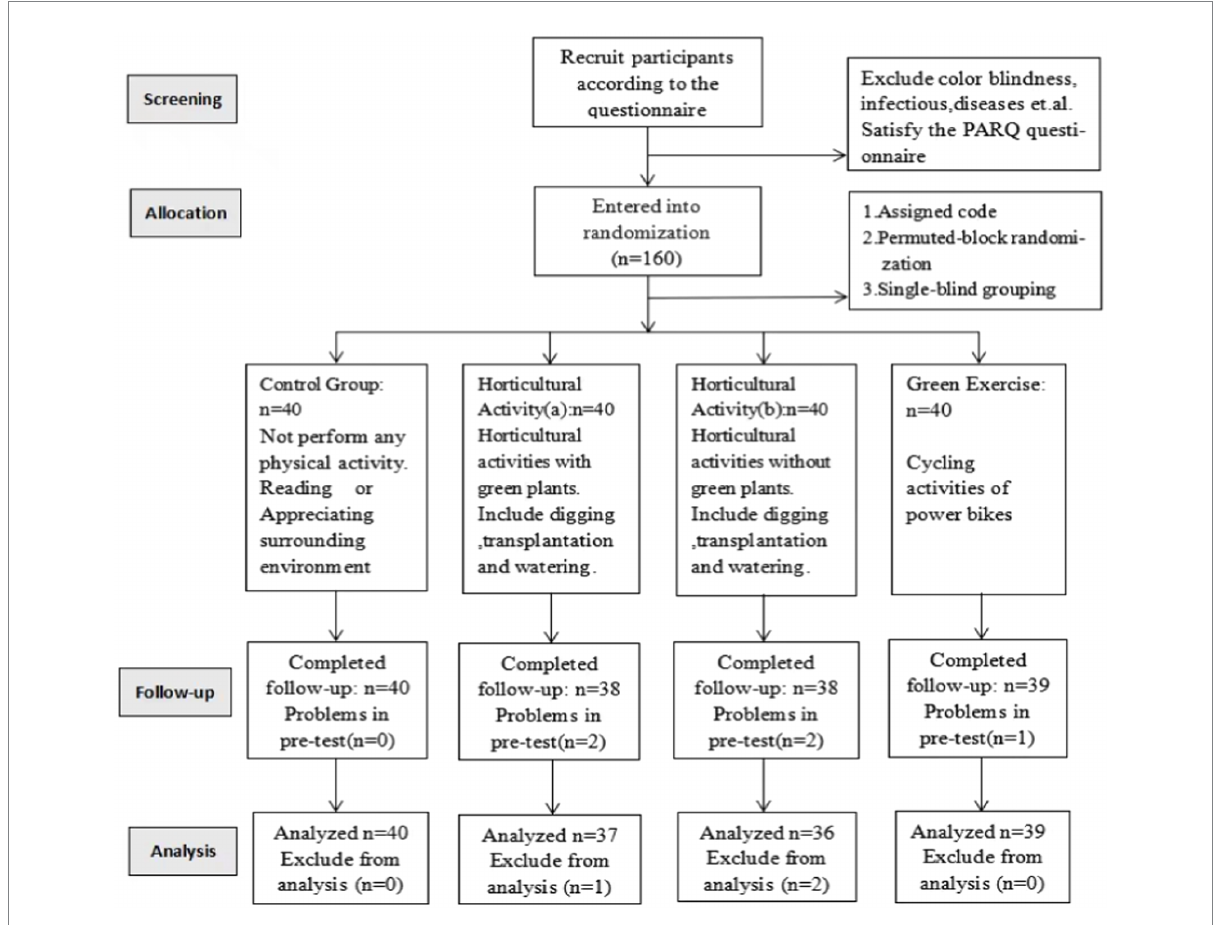
FIGURE 1 Consort chart showing the recruitment, random allocation, follow-up, and analysis of the